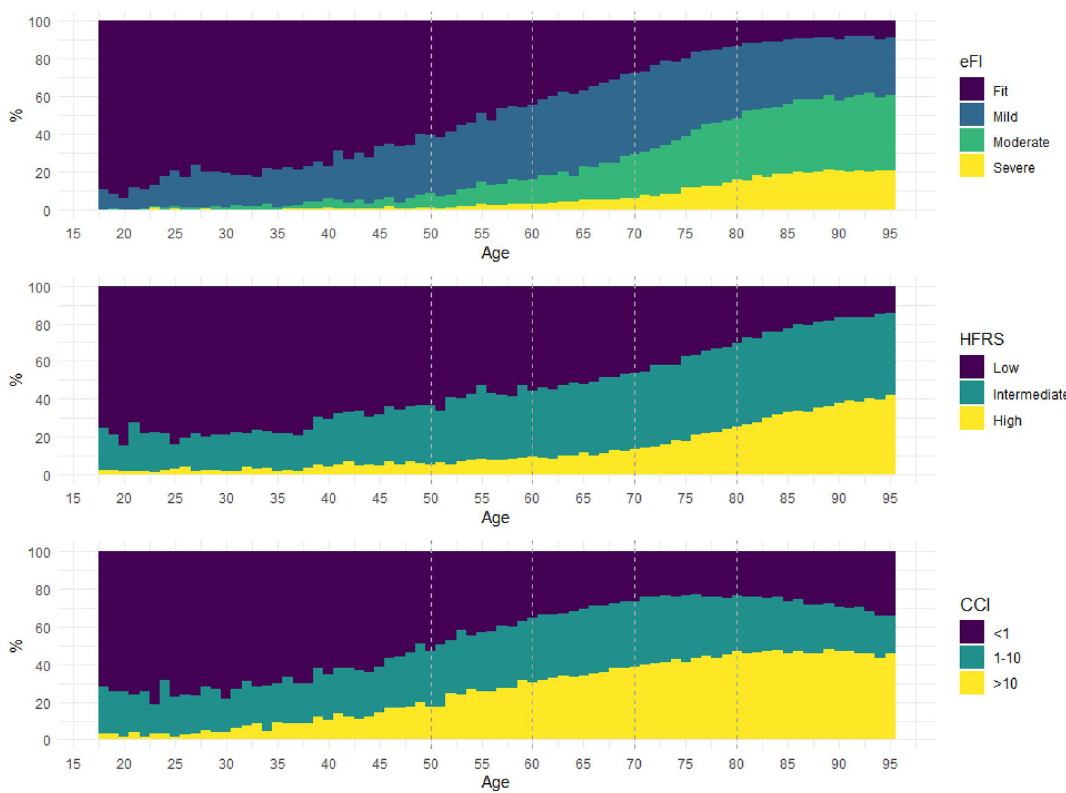
Figure 2. Distribution of frailty and comorbidity categories by age in the cohort. eFI electronic Frailty Index; HFRS Hospital Frailty Risk Score; CCI Charlson comorbidity